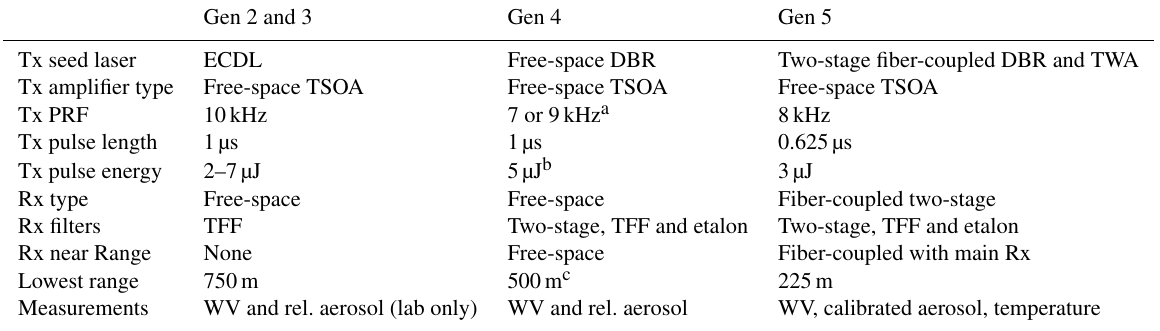
Table 1. Key parameters of the MPD generations. Distributed Bragg reflector (DBR), external cavity diode laser (ECDL), pulse repetition frequency (PRF), receiver (Rx), thin-film filter (TFF), tapered semiconductor optical amplifier (TSOA), traveling wave amplifier (TWA), transmitter (Tx), water vapor (WV).